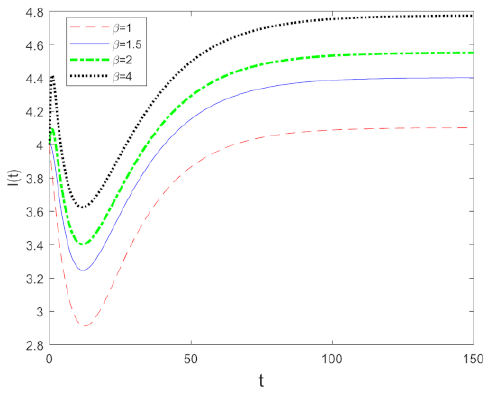
Figure 5. Trends in the number of the rumor spreading with different β